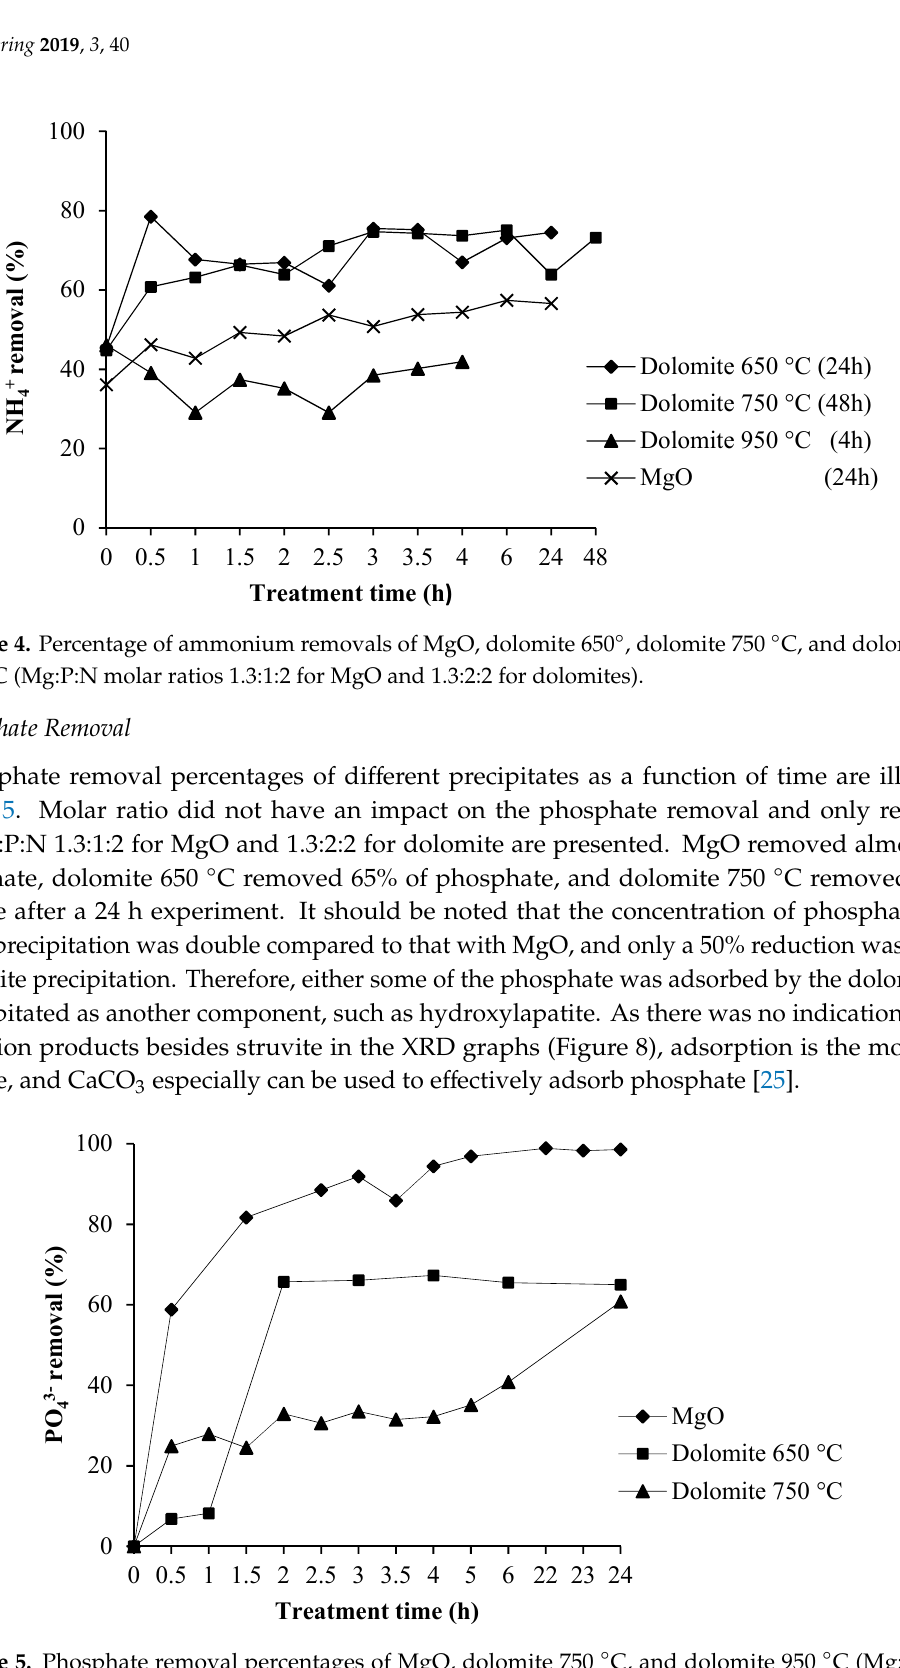
Figure 5 . Phosphate removal percentages of MgO, dolomite 750 °C, and dolomite 950 °C (Mg:P:N molar ratios 1.3:1:2 for MgO and 1.3:2:2 for dolomites).